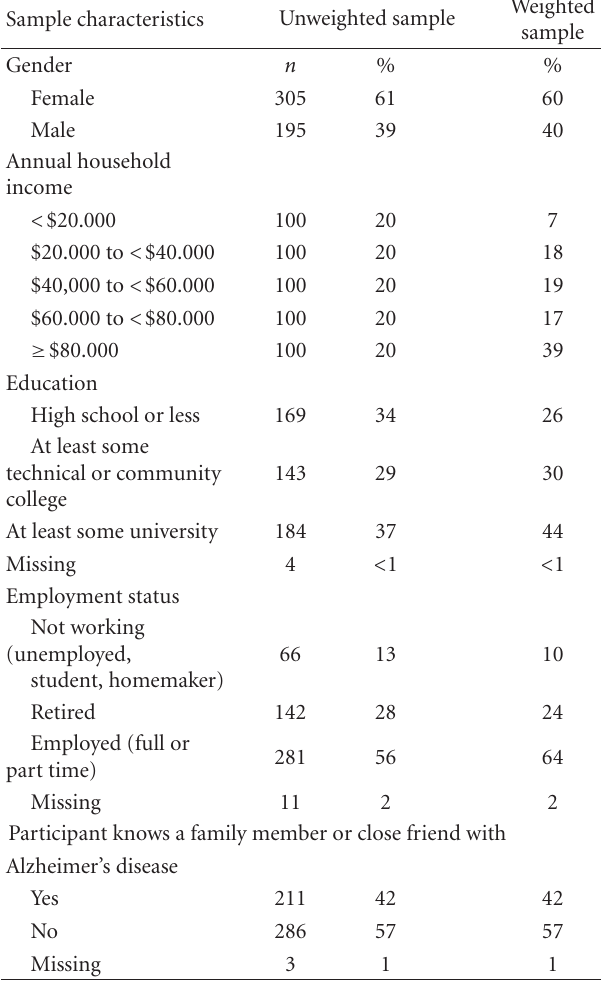
Table 1: Characteristics of participants (unweighted and weighted